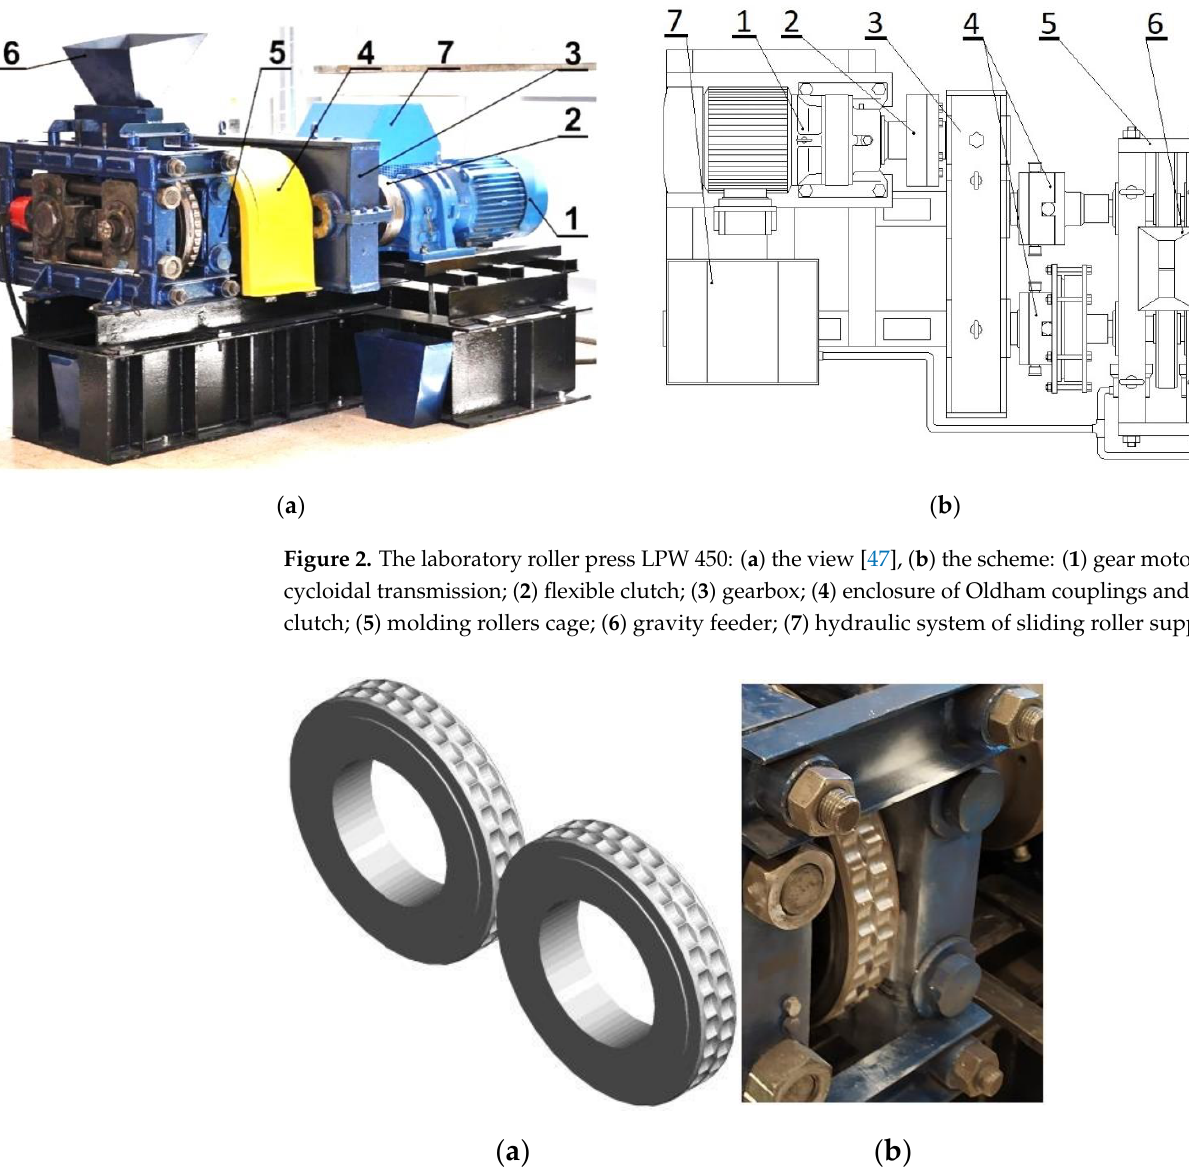
Figure 3. The rollers used in roller press compaction unit with a pillow-shaped briquette: ( a ) scheme of compaction unit and ( b ) the roller installed in the roller press.